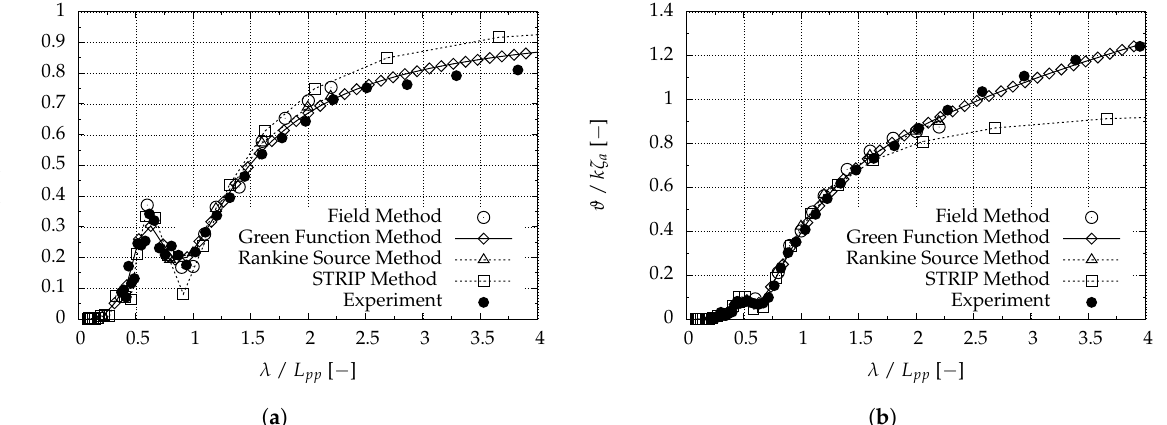
Figure 7. LNG carrier: computed and measured RAOs. ( a ) Heave motion ζ and ( b ) pitch motion ϑ . ζ a is the wave amplitude, k the wave number, λ the wave length and L pp the ship length.